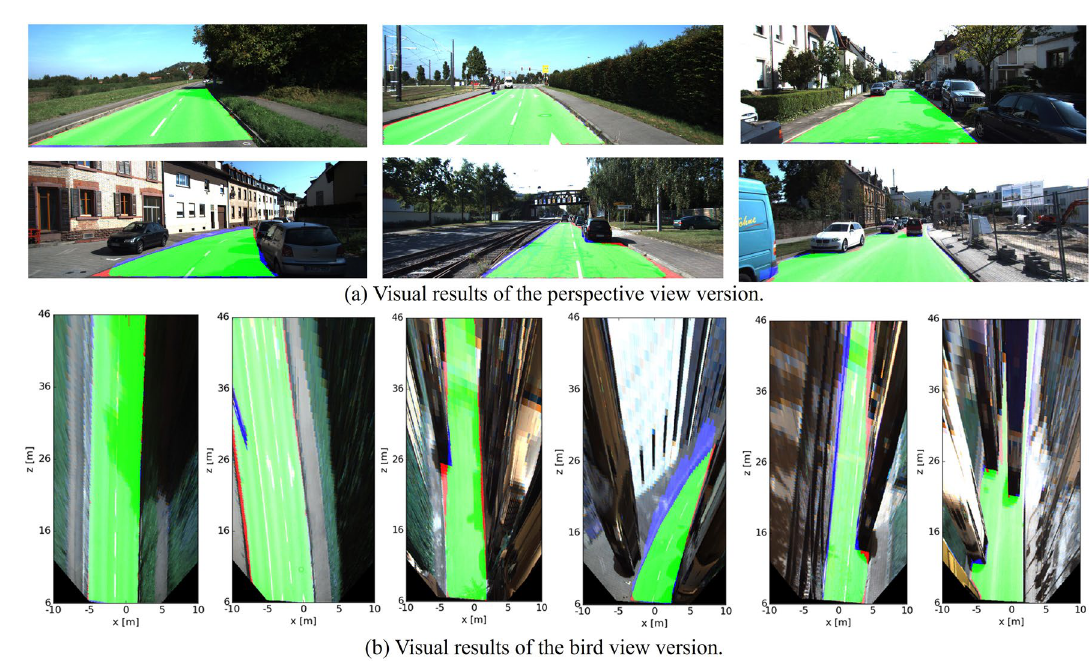
Figure 7. Visual results on the KITTI-ROAD test